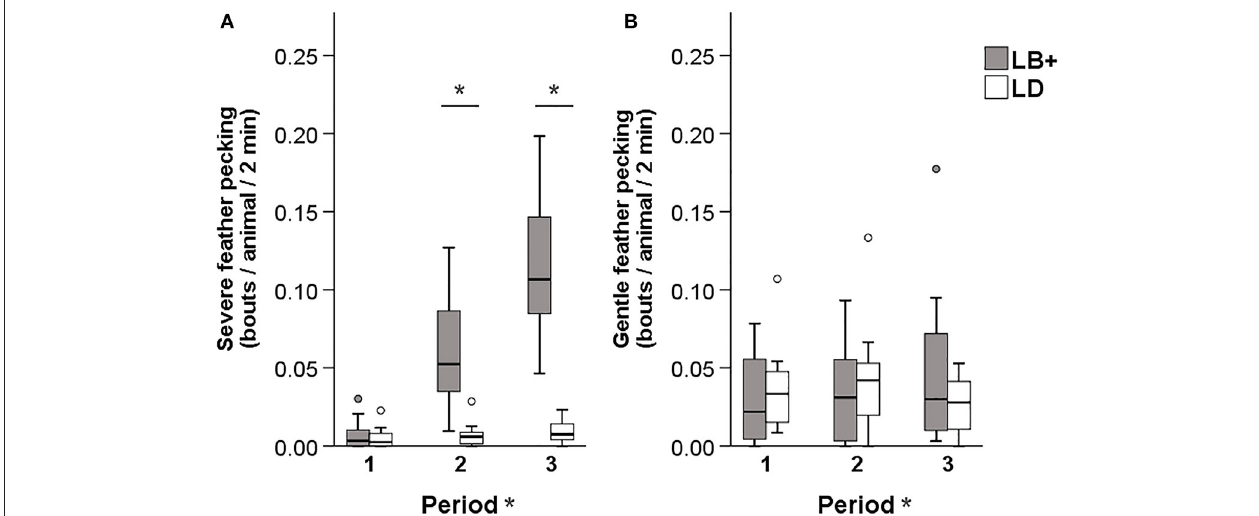
FIGURE 1 | Pecking behavior in conventional layer (LB + ) and dual-purpose (LD) hybrids at three times during the laying period (1: 25th − 30th, 2: 43rd − 48th, 3: 64th − 69th week of life). (A) Severe feather pecking, (B) gentle feather pecking. *Between bars denotes an effect of hybrid ( P < 0.05). *After “Period” denotes an effect of period ( P < 0.05). Both for severe feather pecking and gentle feather pecking a hybrid × period interaction was found ( P < 0.05).